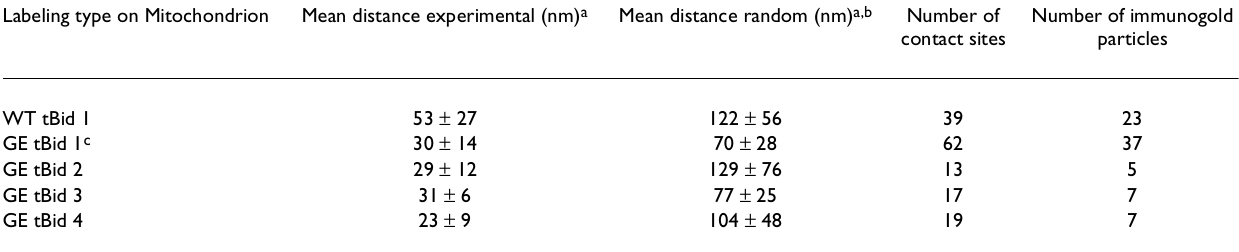
Table 1: Distance from immunogold particles to the nearest contact site in tomographic reconstructions of liver mitochondria Labeling type on